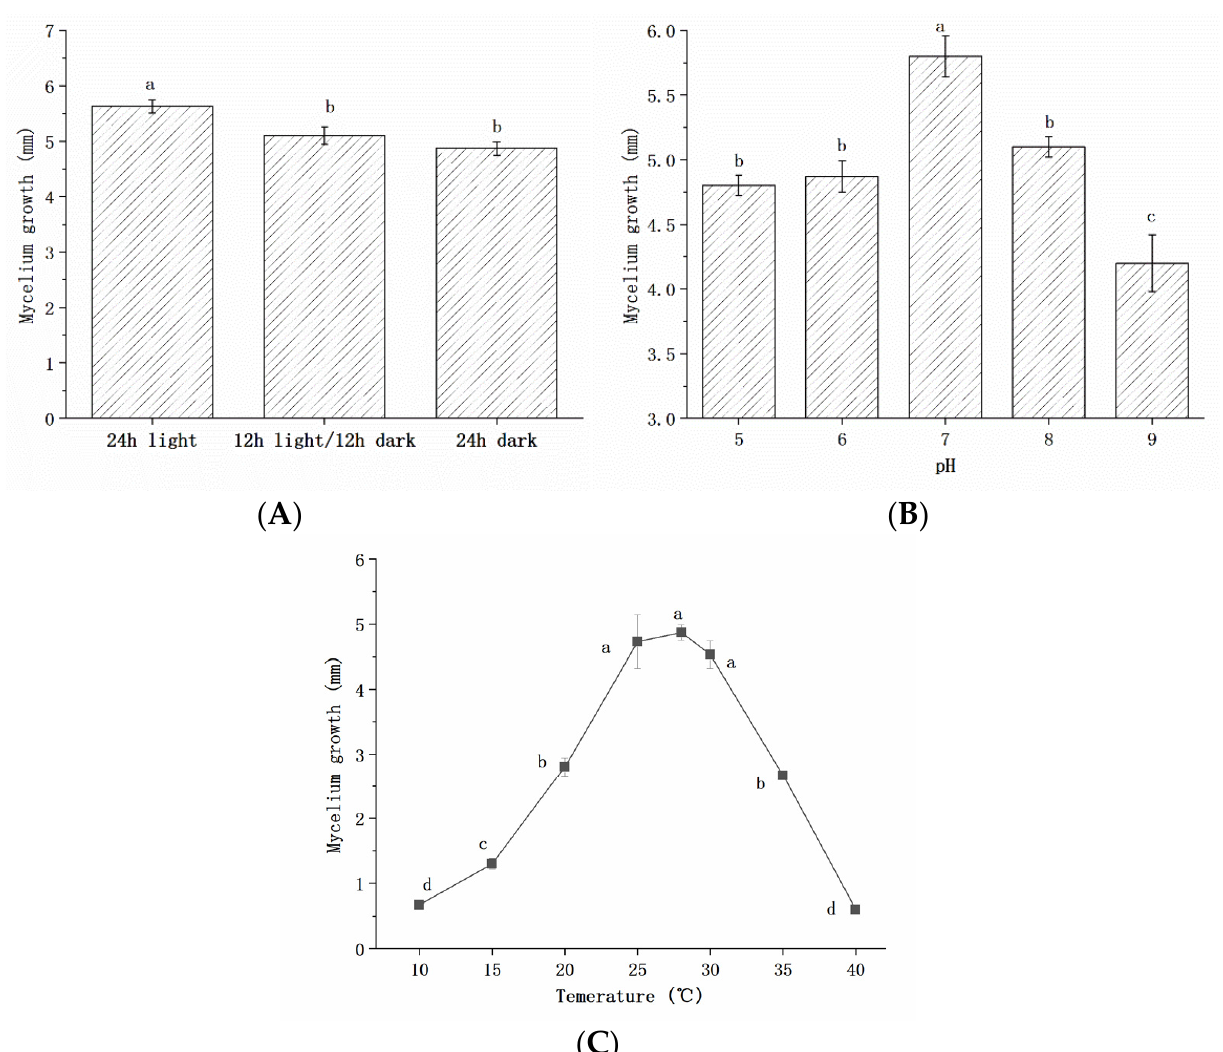
Figure 3. Effects of light illumination ( A ), pH ( B ), and temperature ( C ) on the growth of Bot. dothidea JNHT01. Error bars represent standard deviations of the mean. a–d: different letters indicate significant differences with a p < 0.05.